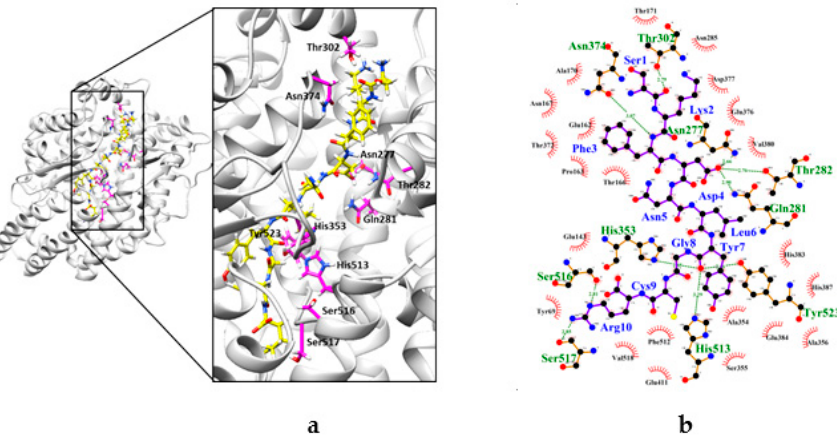
Figure 4. Interaction between CSBp5 and ACE by docking analysis. ( a ) Docking structure of ACE complexed with CSBp5. Close-up view of ACE complexed with CSBp5 is shown on the right panel. The structure of CSBp5 and ACE are represented by yellow stick and white ribbon, respectively. The side chains of residues forming hydrogen bonds with CSBp5 are shown as pink sticks. ( b ) The LigPlus schematic 2D representation of CSBp5-ACE interaction. The amino acid residues of CSBp5 are shown as purple sticks and labeled in blue. Hydrogen bonds between CSBp5 and ACE are represented by green dashed lines. The amino acid residues of ACE interacted with CSBp5 are shown as brown sticks and labeled in green.